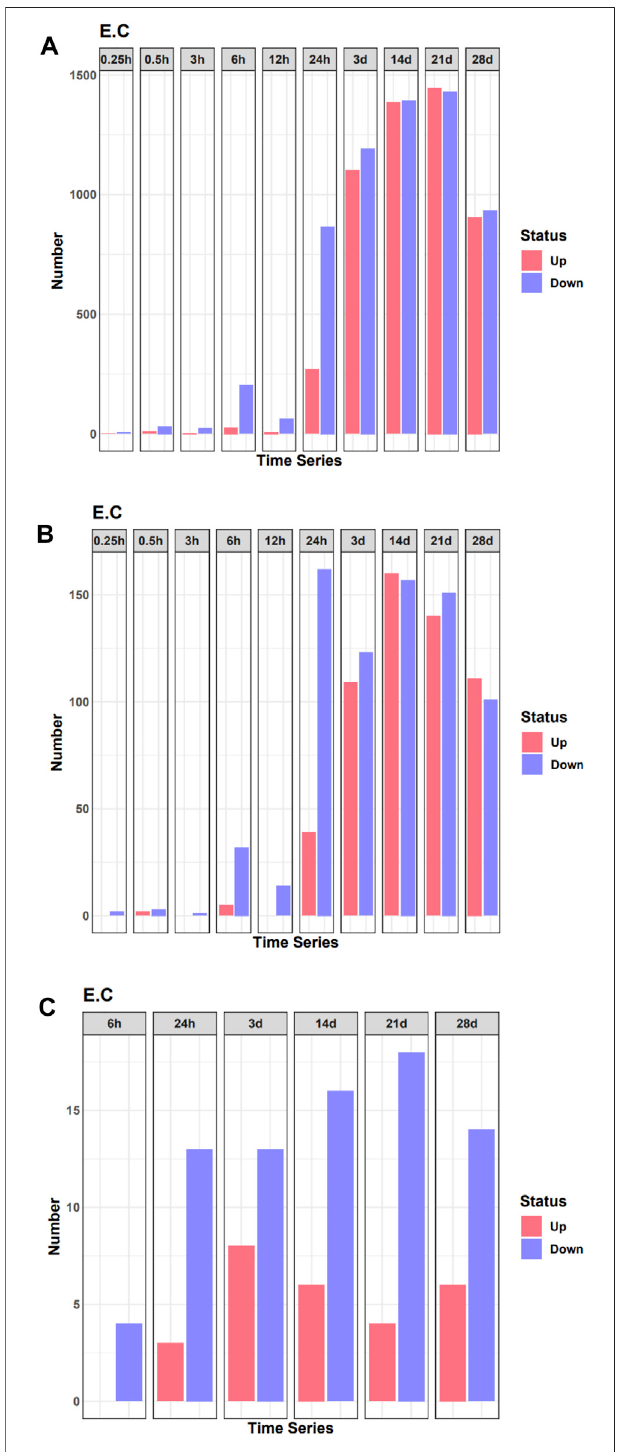
FIGURE1| Quanti fi cationofdifferentially expressedgenes(DEGs)inthe denervatedandsham groupsateach timepointexamined. (A) Thenumberof DEGs at each time point. (B) The number of DEGs of transcription factors (TFs) at each time point. (C) The number of differentially expressed TF genes related to the pathophysiology of skeletal muscle at each time